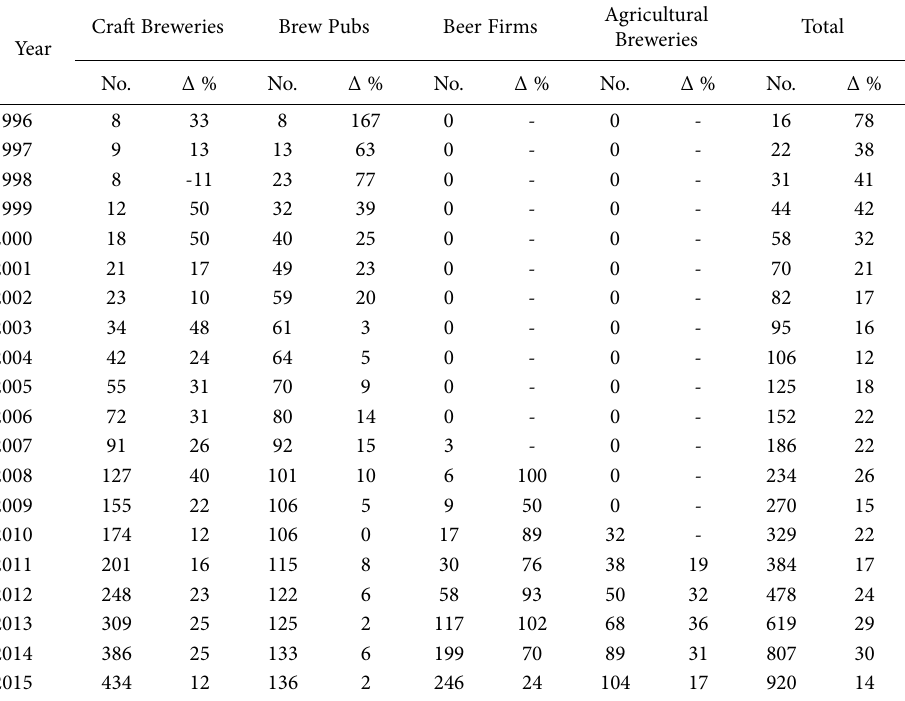
Table 2. Active microbreweries in Italy by typology (1996 – 2015). Variations (Δ %) refer to the previ- ous